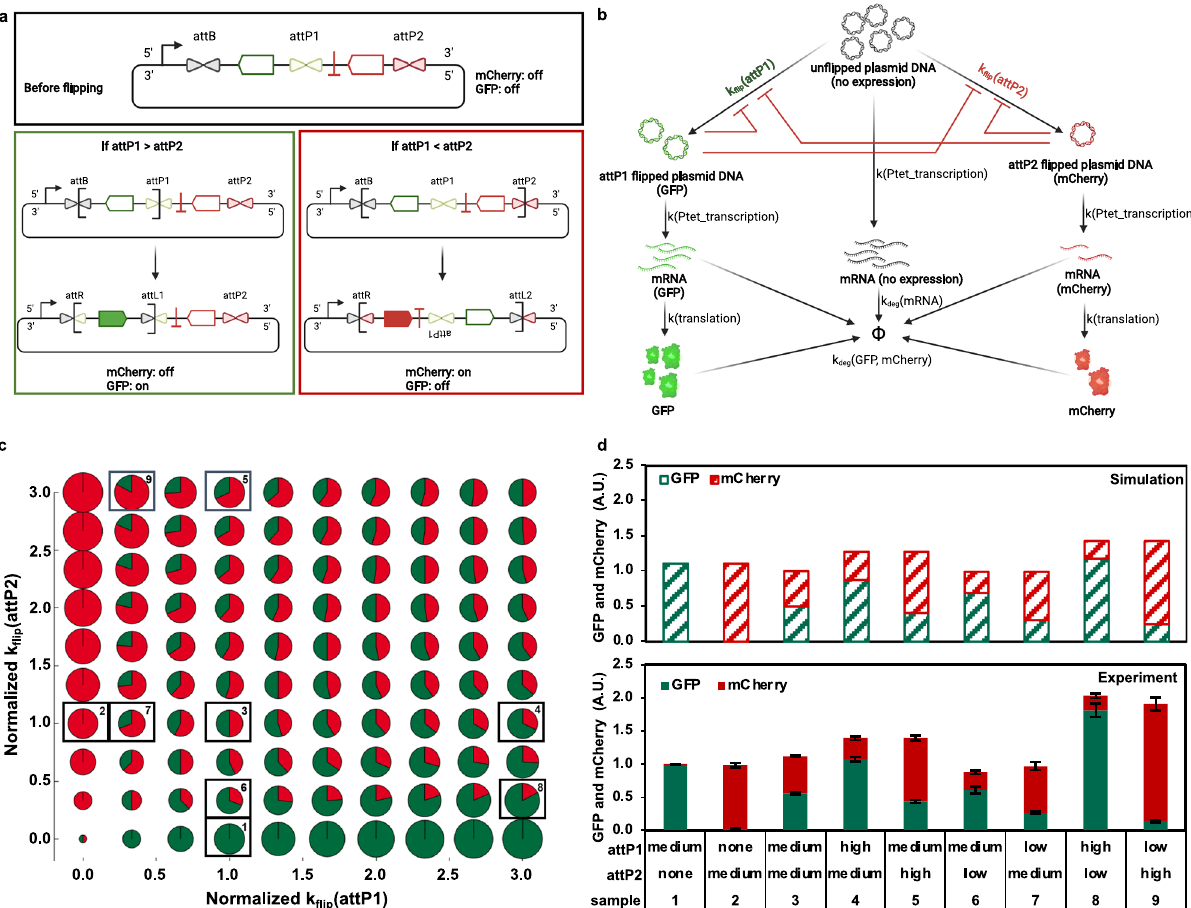
Fig. 6 Use of attP variants with predictable DNA recombination rates to coordinate co-expression of GFP and mCherry in E. coli . a Plasmid design for GFP and mCherry co-expression. At the top is the plasmid construct before fl ipping. A reversed GFP gene, fl anked by attB and attP1, and a reversed mCherry gene, positioned between attP1 and attP2, are placed downstream of a promoter; attP1 and attP2 are variants with different DNA recombination rates. When the recombination rate of attP1 is larger than that of attP2 (bottom left), the GFP gene in the bracket will be preferentially fl ipped and transcribed. When the recombination rate of attP2 is larger than that of attP1 (bottom right), the entire construct in the bracket, which includes both the GFP and mCherry genes, will be fl ipped; however, due to the terminator immediately after the mCherry gene, only mCherry is expressed. The use of a high-copy plasmid ensures more robust ratiometric control of the co-expressed fl uorescent proteins. b Schematic of the GFP/mCherry co-expression network in E. coli , used to construct a mechanistic model (Supplementary Method 3). c Bubble pie chart of simulations of the mCherry/GFP co-expression levels in E. coli using attP1 and attP2 variants with different DNA fl ipping rates. The green and red colors indicate relative proportions of GFP and mCherry expression, respectively, and the pie size indicates the total expression of fl uorescent protein. The predictions tested experimentally in d are boxed and numbered on this pie chart. d Simulated (top) and experimental (bottom) GFP and mCherry expression levels for different attP1 and attP2 combinations, after 12-h incubation in M9 medium at 37°C and normalized by cell density. Across the sample set, the low attP sequence was C14A; the medium attP sequence was WT; and the high attP sequence was S2 (G5T, G12A, G17A). The relative expression level was normalized by sample 1: WT attP1 and no attP2. Experimental data are the mean values of three biological replicates, with error bars representing standard deviations. Source data are provided as a Source Data fi